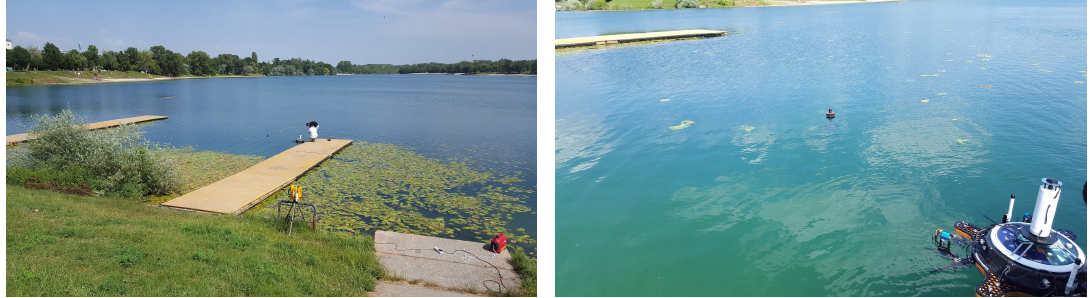
Figure 17. Structured docking experiment at lake Jarun. Experimental environment ( left ) and experiment in progress ( right ).